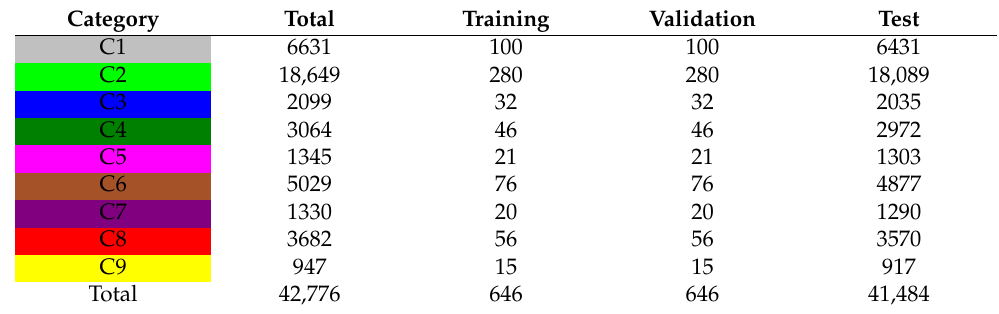
Table 1. Category information and corresponding experimental sample size for UP.